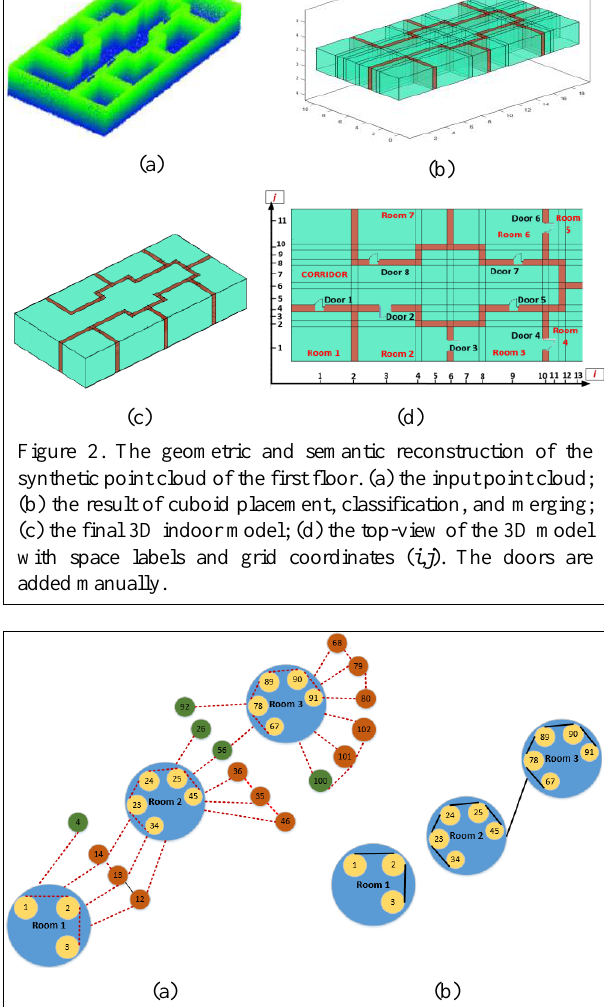
Figure 3. Topology graphs reconstructed for the first floor of the synthetic point cloud containing adjacency and containment relations (a), and connectivity and containment relations